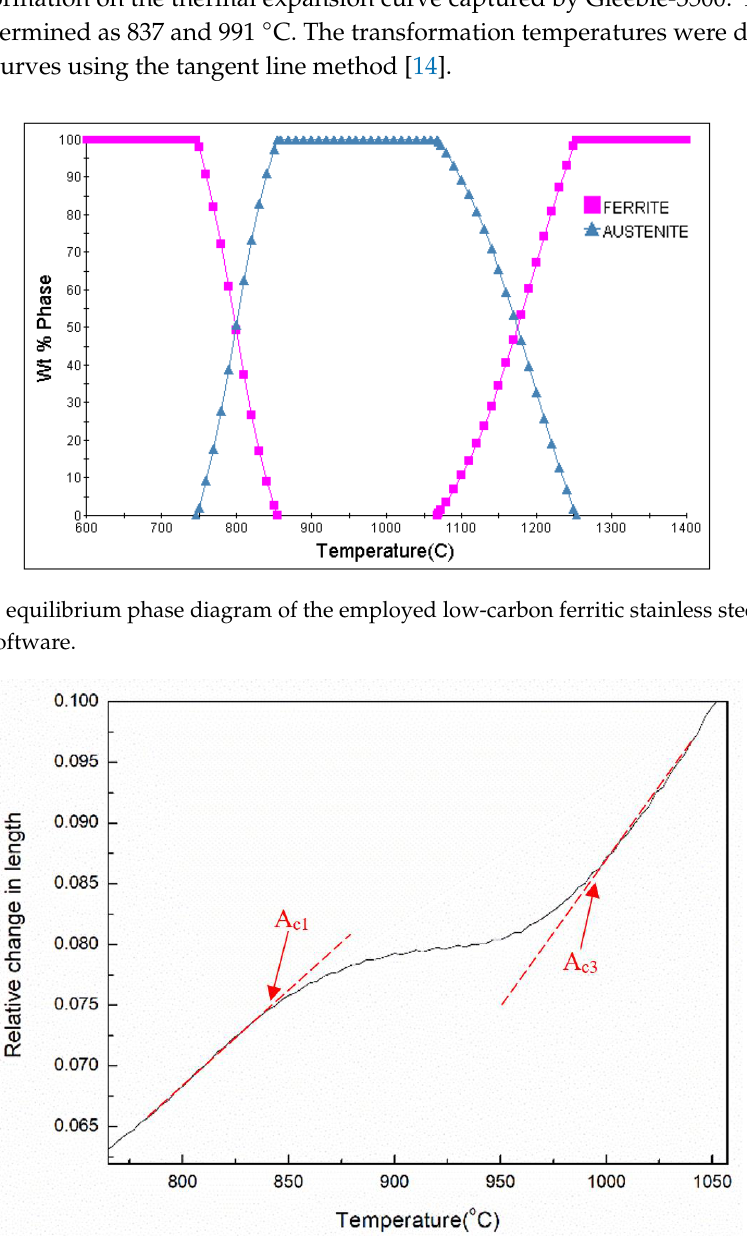
Figure 5. Continuous cooling transformation (CCT) diagram of the explored low-carbon ferritic stainless steel in this work calculated by JMatPro software. Figure 6. Microstructure of the low-carbon ferritic stainless steel sample after austenitization: ( a ) optical micrograph, ( b ) SEM micrograph.